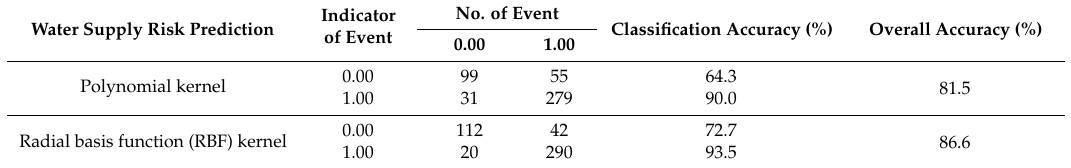
Table 2. Analysis of water risk prediction model using Support Vector Machine (SVM).